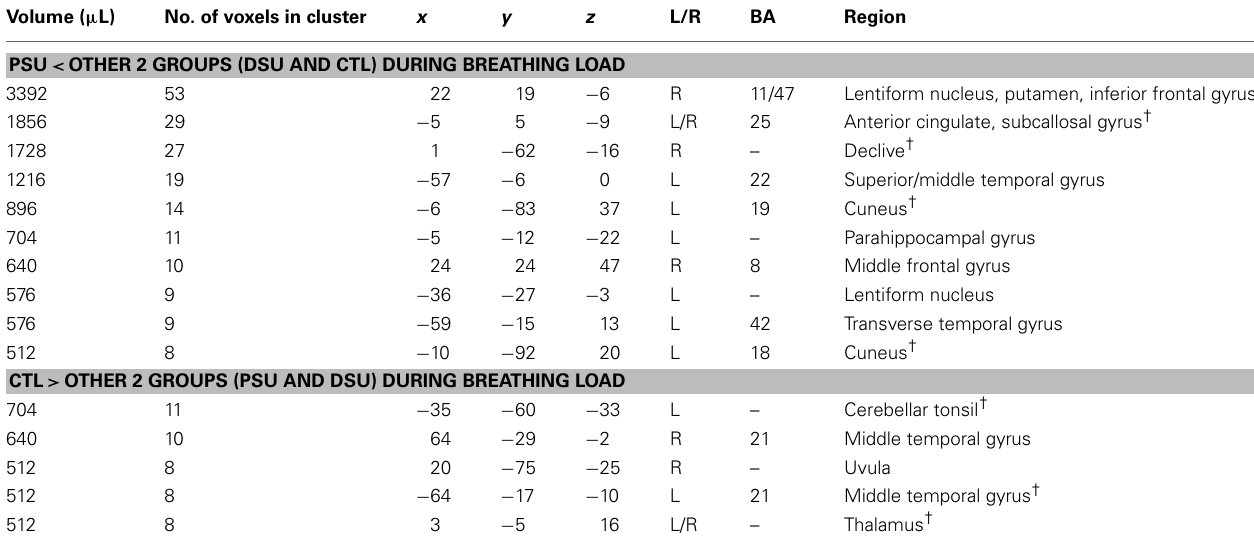
L, left hemisphere; R, right hemisphere; BA, Brodmann Area; PSU, Problem Stimulant Users; DSU, Desisted Stimulant Users; CTL, Healthy Comparison